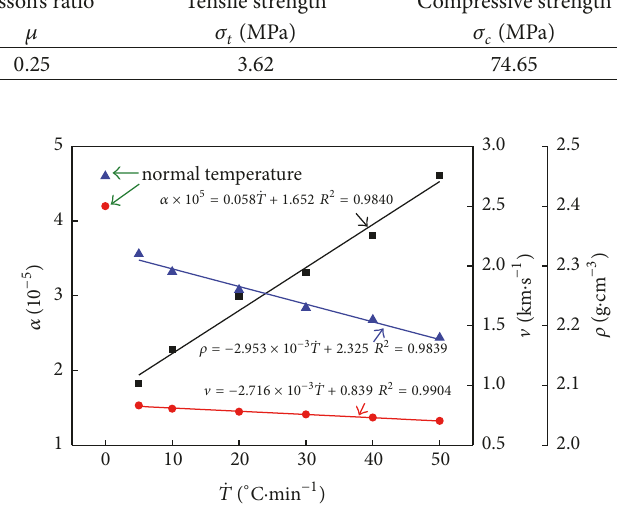
Figure 3: Relationship between physical parameters and heating rates. V is the longitudinal wave velocity, 𝜌 is the density, and 𝛼 is the thermal expansion